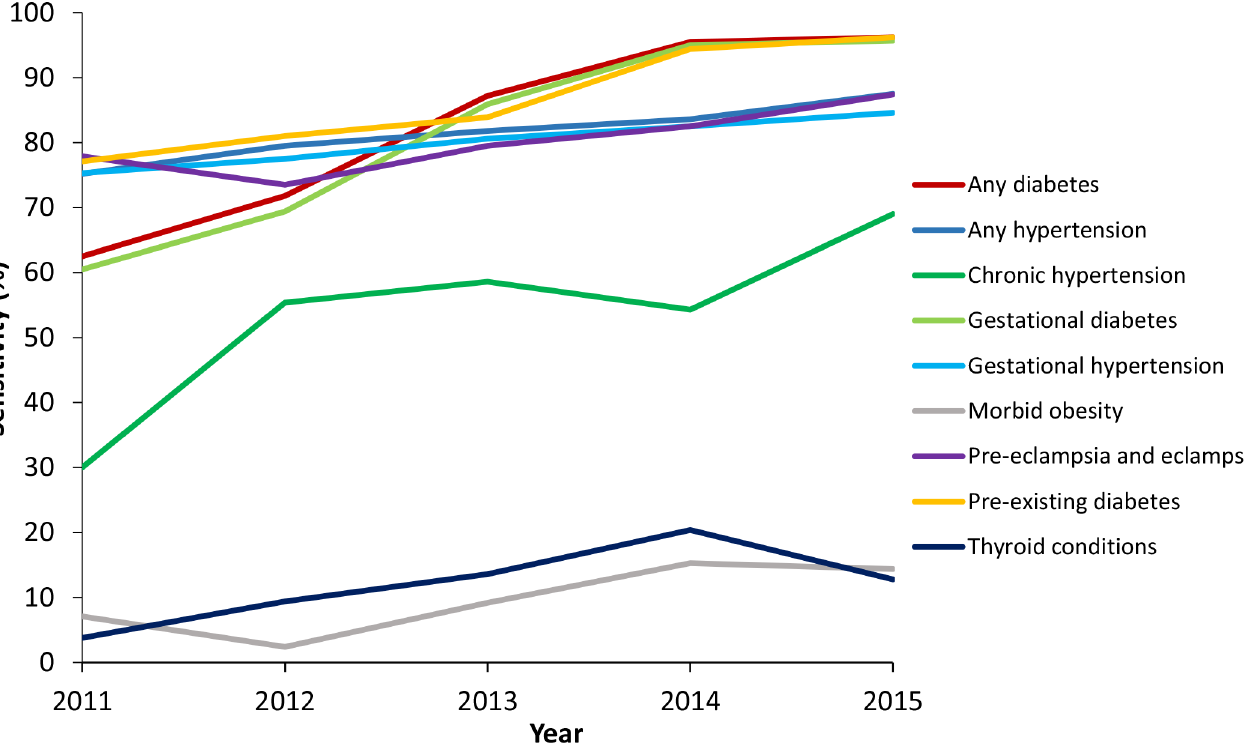
Figure 2: Sensitivity for maternal conditions reported in coded hospital data from two tertiary hospitals in New South Wales, by year, compared to ObstetriX data as the reference